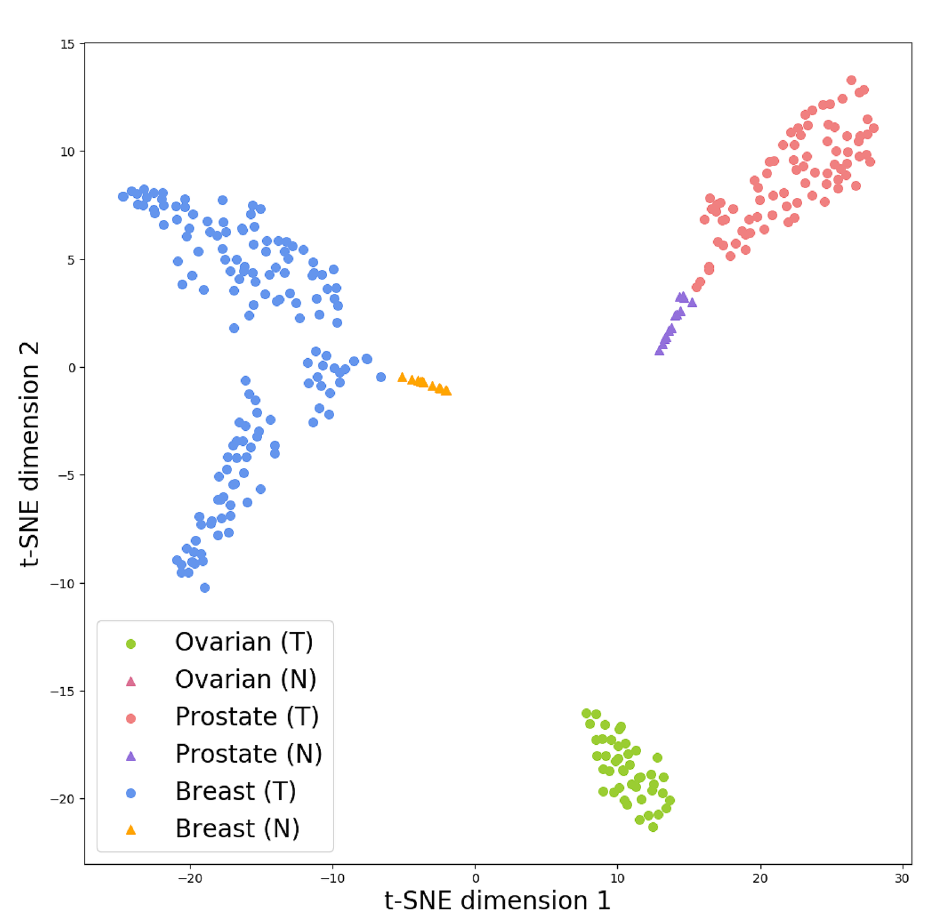
Figure 3. The T-SNE analysis using the 12 dimensional latent representation from our network can generally separate the classes into distinguishable